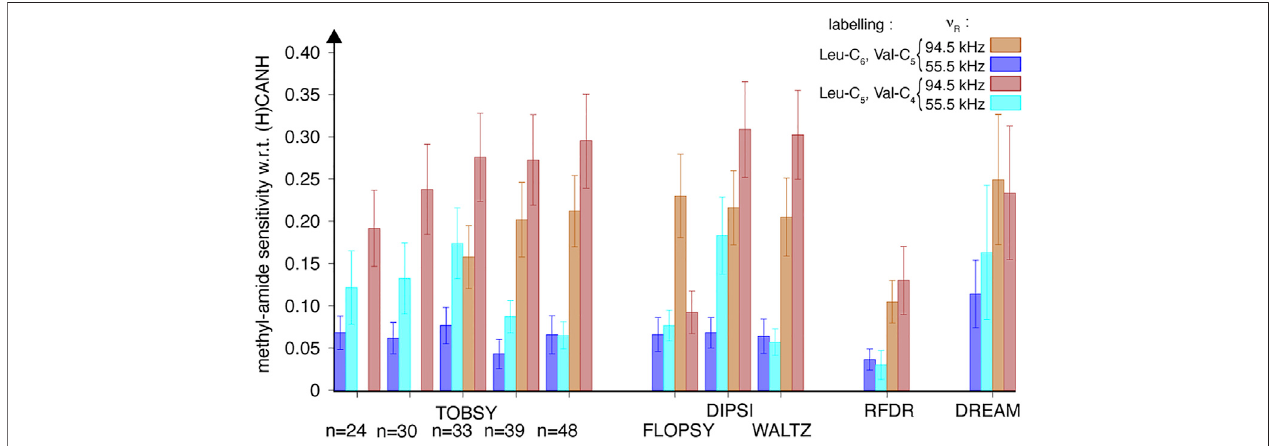
FIGURE11| Relativeef fi ciencyof 13 CmixingschemescomparedbetweentwoSH3proteinsamples:withbranched( “ ILV-C5 ” , tan fi lledbars)andlinear( “ ILV-C4 ” , red fi lledbars) 13 Cspinsystemsofleucineand valineresidues,quanti fi edusing24cross-peakintensitiesin3D(H)C(CC)(CA)NH spectrarecordedataMASfrequencyof 94.5 kHz on an 18.8-T spectrometer. Data for 55.5 kHz MAS is shown as blue and cyan bars for “ ILV-C5 ” and “ ILV-C4 ” SH3 samples, respectively. Sensitivity of each cross-peakwasnormalizedtorespectiveintra-residuepeakin3D(H)CANHspectrumateachsampleandspinningcondition,andsubsequentlyaveragedoverVal, Leu, and Ile residues.